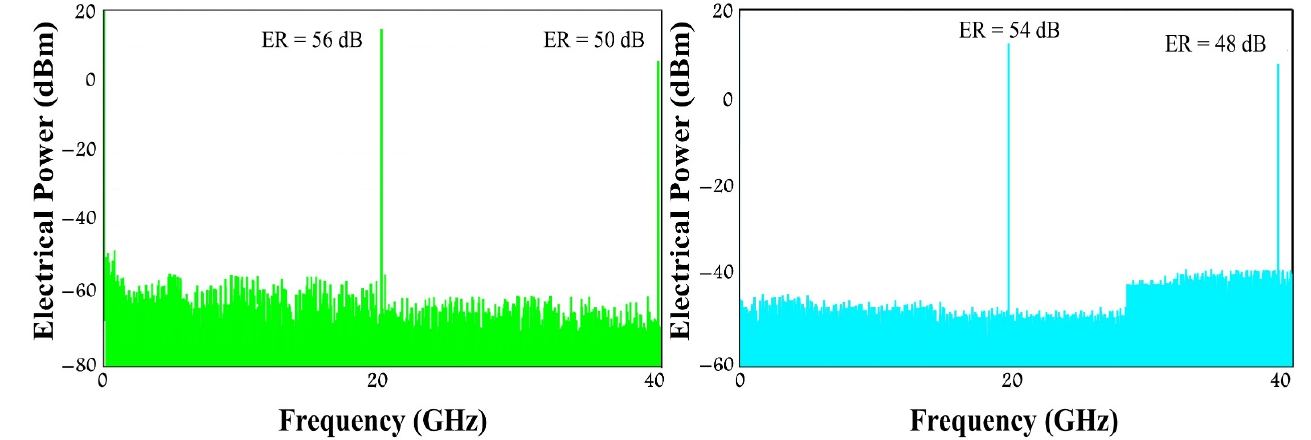
Figure 6. Simulation (at left ) and experimental (at right ) results for the “AND” gate signal contingent on the SOA-MZI differential modulation concept. ER: Extinction ratio.